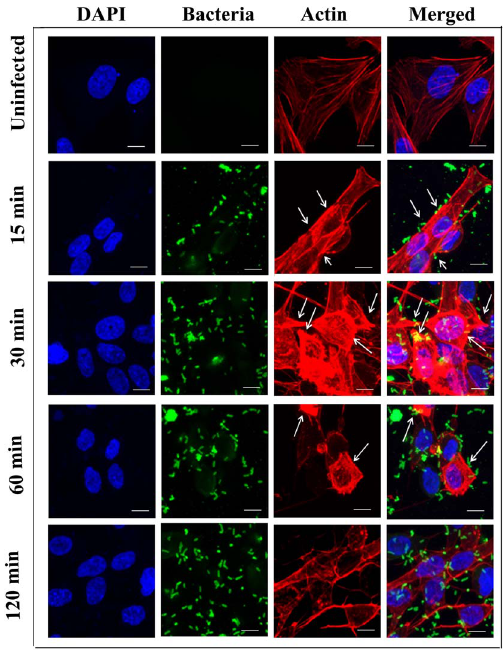
Figure 6. P. aeruginosa induces cytoskeletal rearrangements during invasion of HMEECs. Cells were either left uninfected or infected with P. aeruginosa at an MOI of 10 for 15 min, 30 min, 60 min and 120 min. Bacteria were stained with anti- P. aeruginosa antibody followed by a secondary Alexa Fluor H 488 antibody. Actin was stained with rhodamine phalloidin and then mounted in medium containing DAPI. Results are representative of four independent experiments carried out in triplicate. Arrows indicate actin accumulation. Scale bars 10 m m.